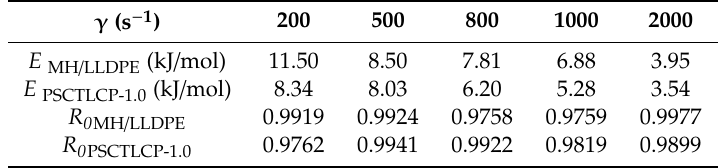
Figure 9. The logarithm of apparent viscosity, η a , versus 1 / T, of ( a ) MH / LLDPE and ( b ) PSCTLCP-1.0 at di ff erent shear rates. Table 3. Values of E and R 0 of MH / LLDPE and PSCTLCP-1.0 at di ff erent shear